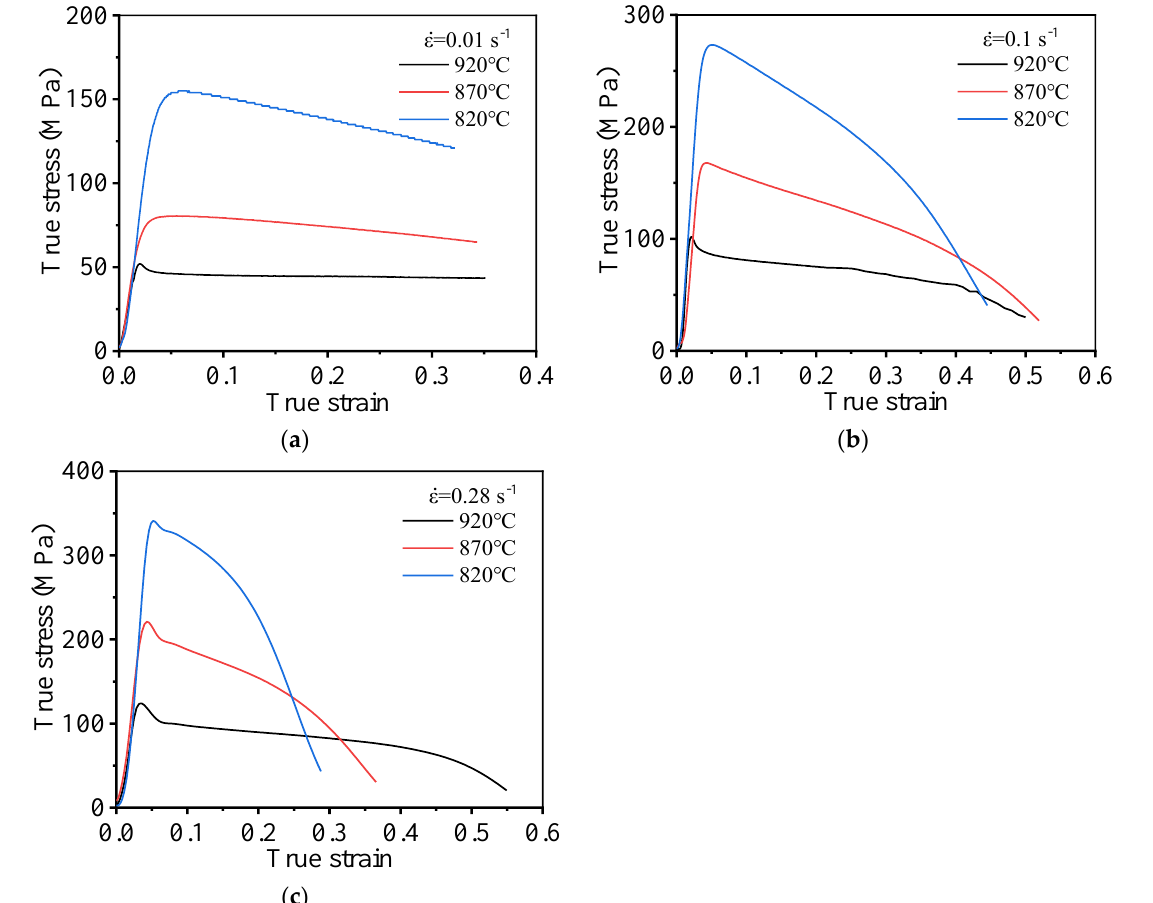
Figure 4. True stress – true strain curve under different deformation strain rates: ( a ) 0.01 s −1 ; ( b ) 0.1 s −1 ; ( c ) 0.28 s −1 .